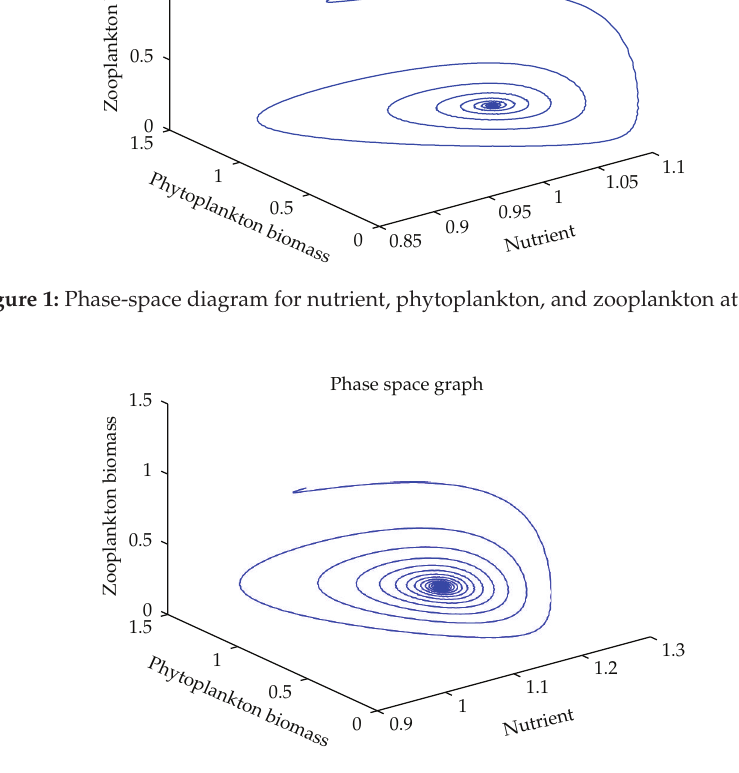
Figure 2: Phase-space diagram for nutrient, phytoplankton, and zooplankton at α (cid:7) 1 .